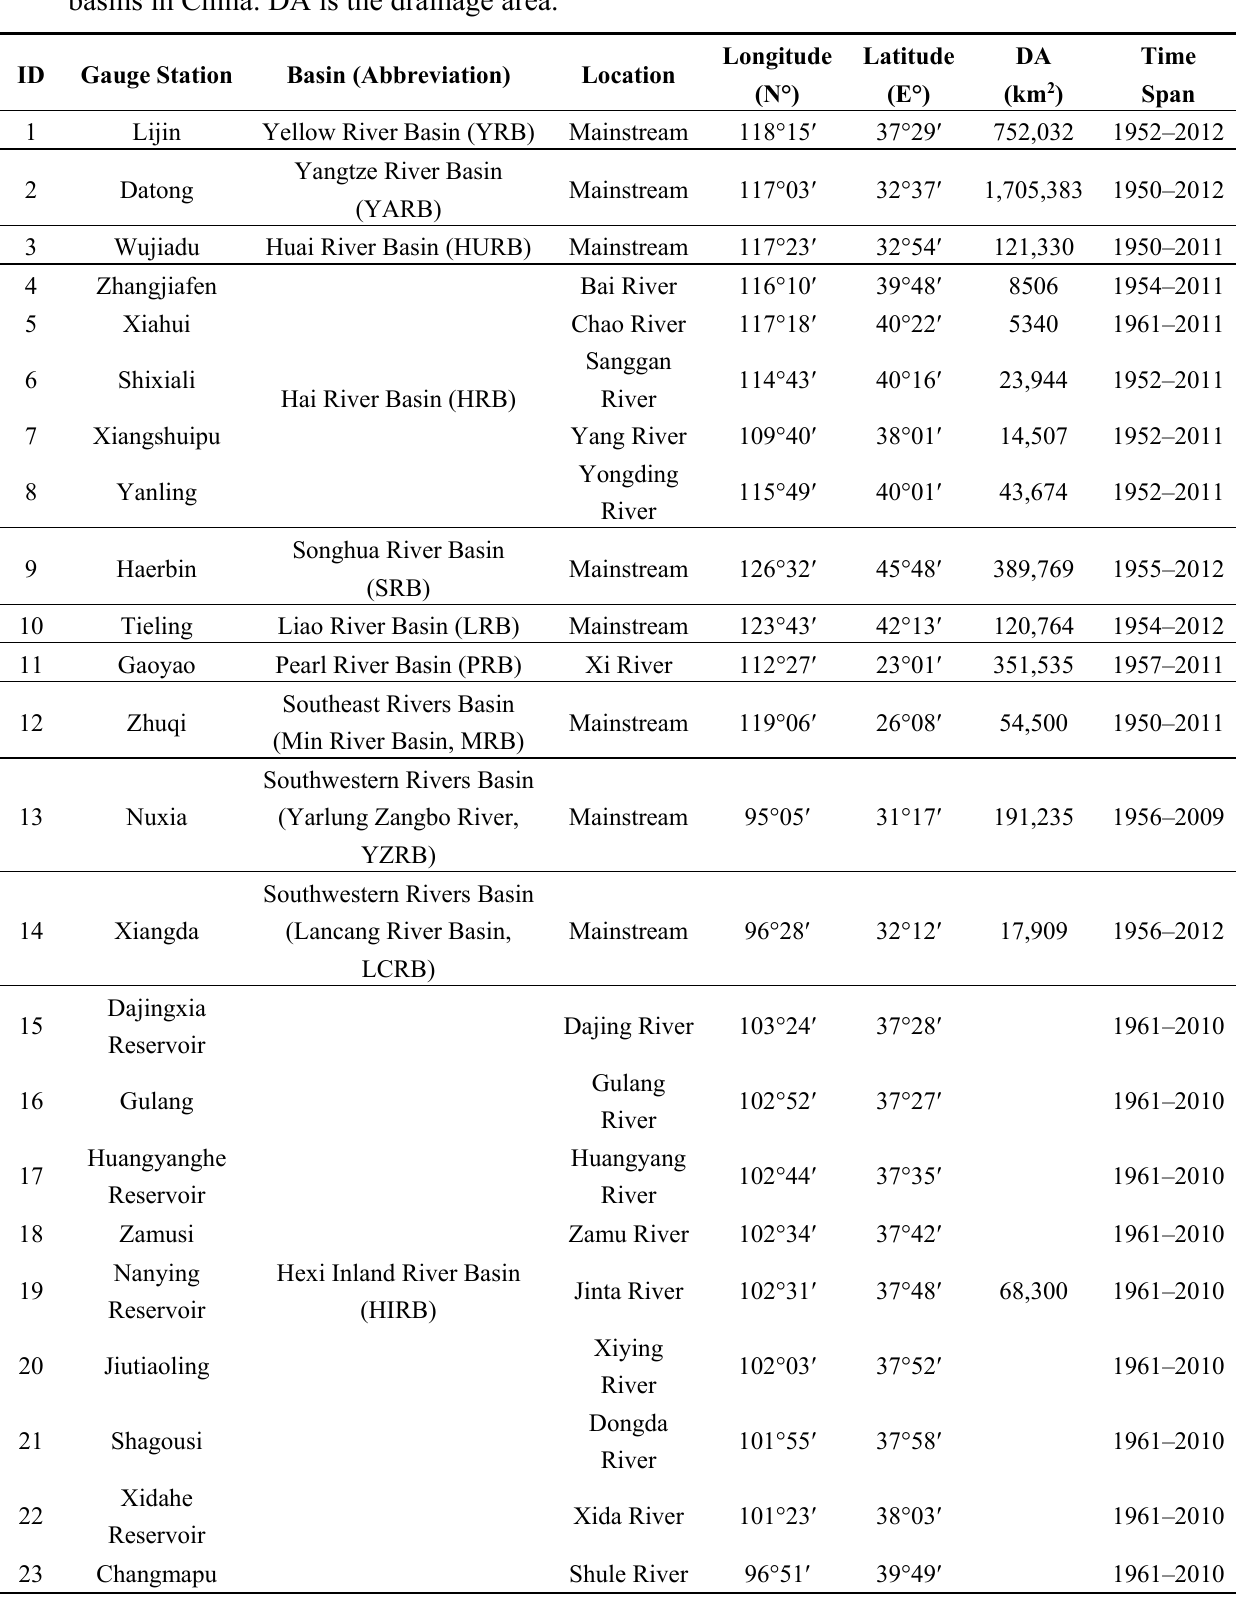
Table 1. Summary of gauging stations and hydrological characteristics in the 12 major basins in China. DA is the drainage